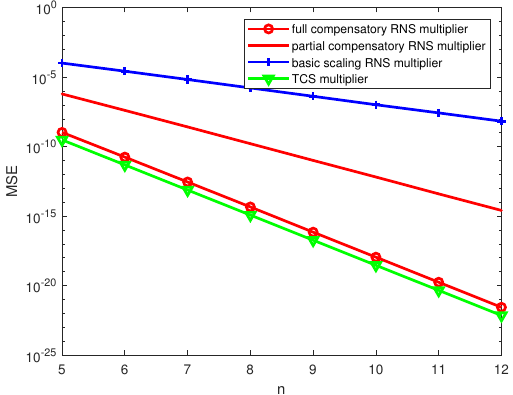
Figure 6. MSE of three kinds of